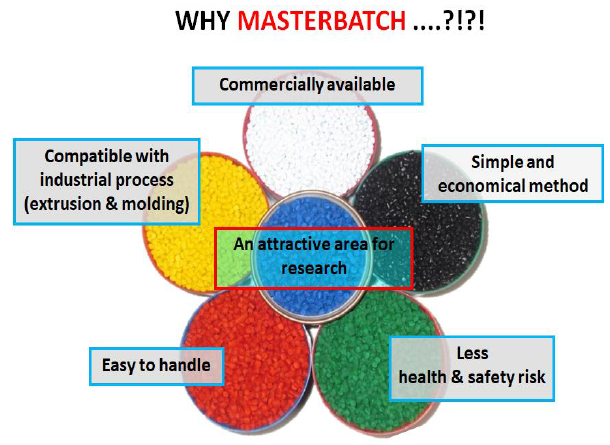
Fig. 1. The reasons of using masterbatch as a processing rute to prepare nanocomposites